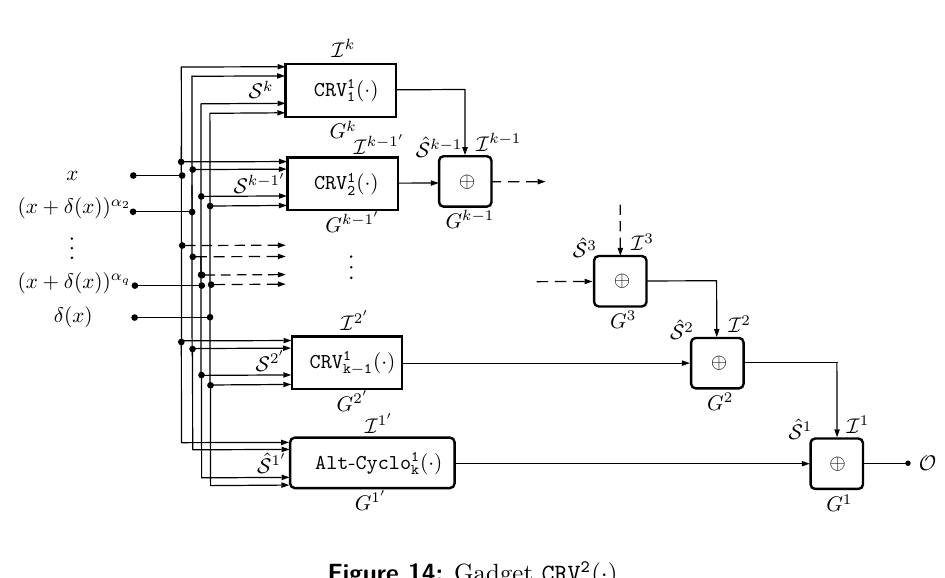
Figure 14: Gadget CRV 2 ( ·